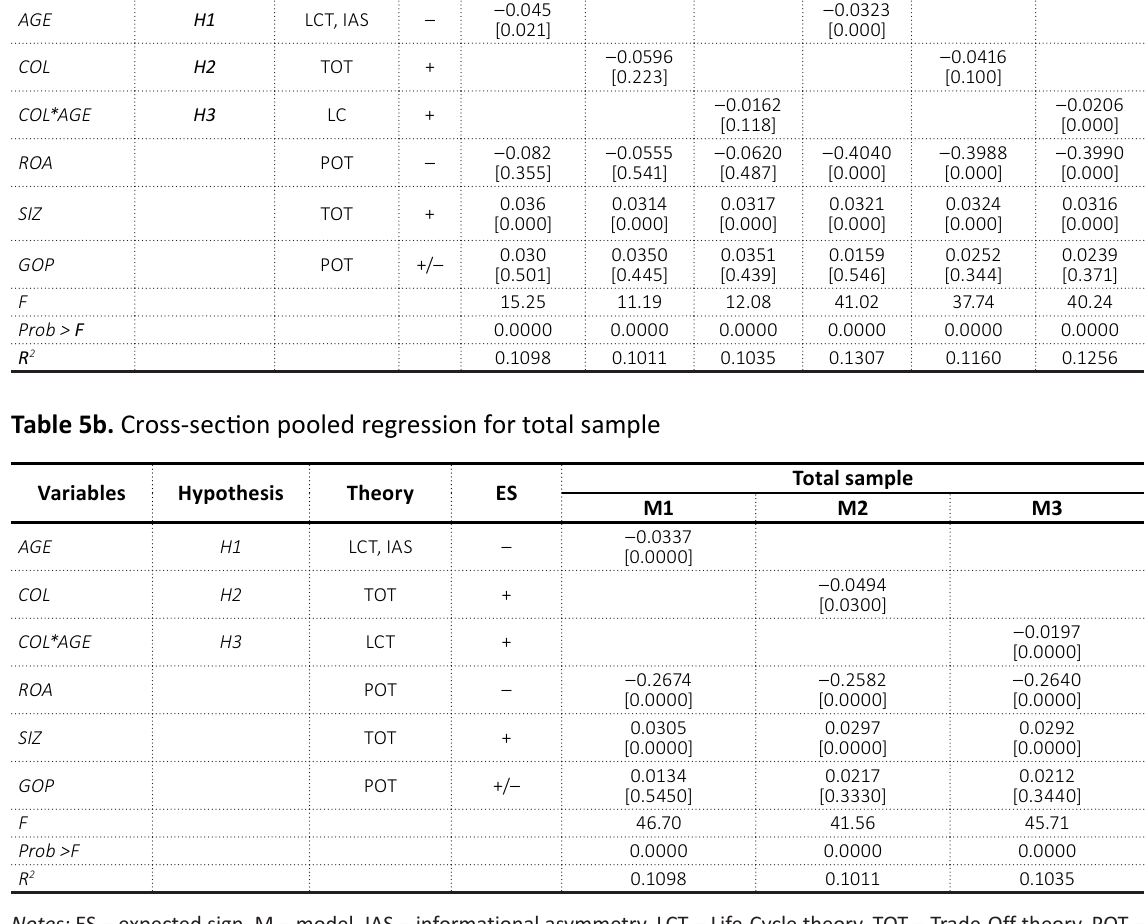
Table 5a. Cross-section pooled regression for public and private sub-samples Variables